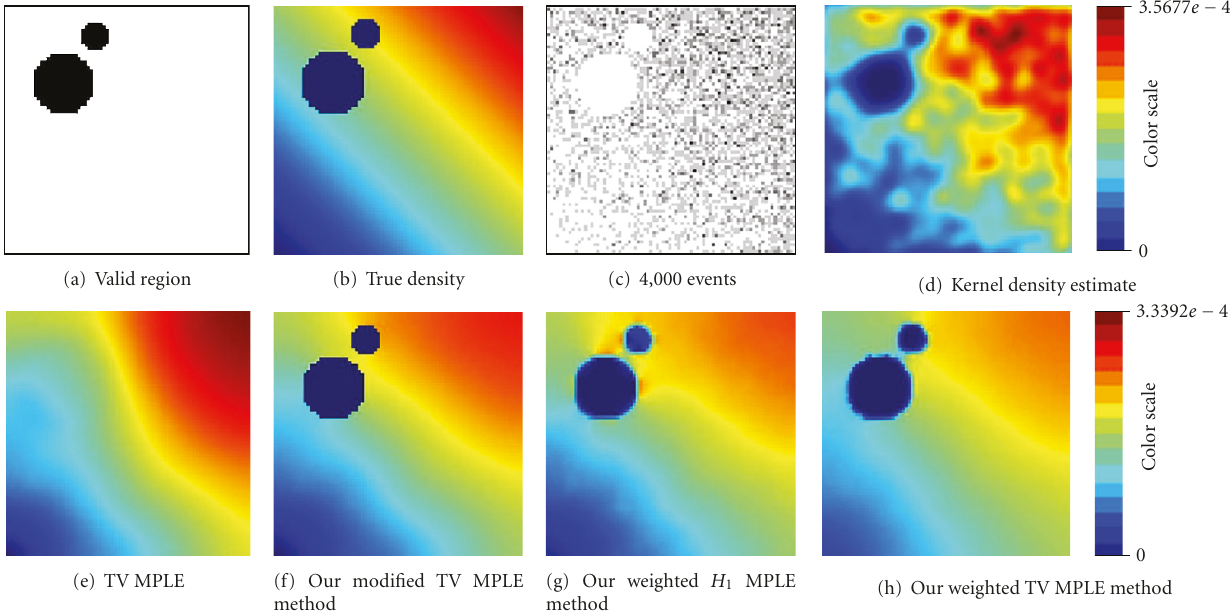
Figure 1: This is a motivating example that demonstrates the problem with existing methods and how our methods will improve density estimates. (a) and (b) give the valid region to be considered and the true density for the example. Figure (c) gives the 4000 events sampled from the true density. (d) and (e) show two of the current methods used. (f), (g), and (h) show how our methods will produce better estimates. The color scale represents the relative probability of an event occurring in a given pixel. The images are 80 pixels by 80